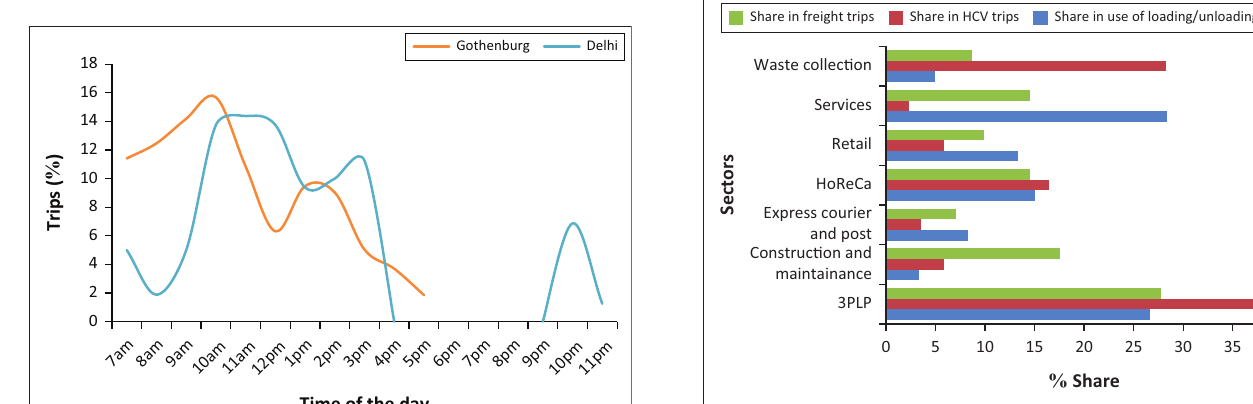
FIGURE 3: The share of different sectors in freight traffic in the study zone at Gothenburg,